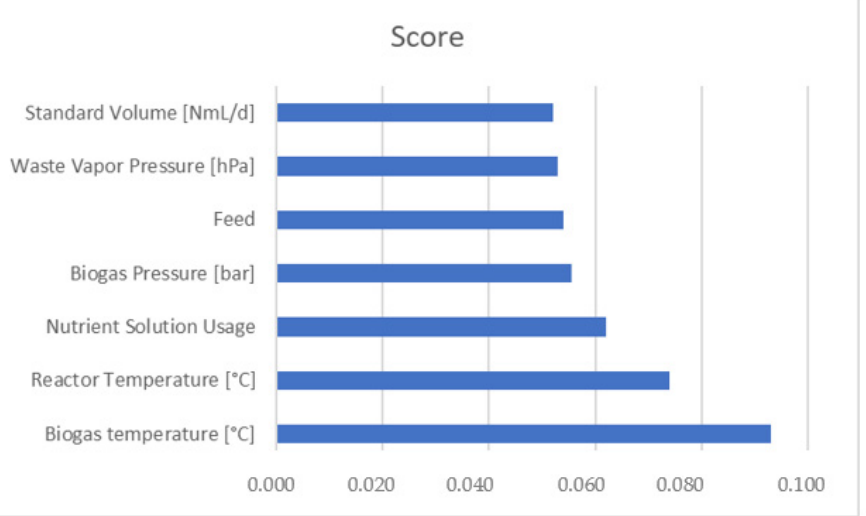
Figure 6. Permutation Feature Importance for kNN.